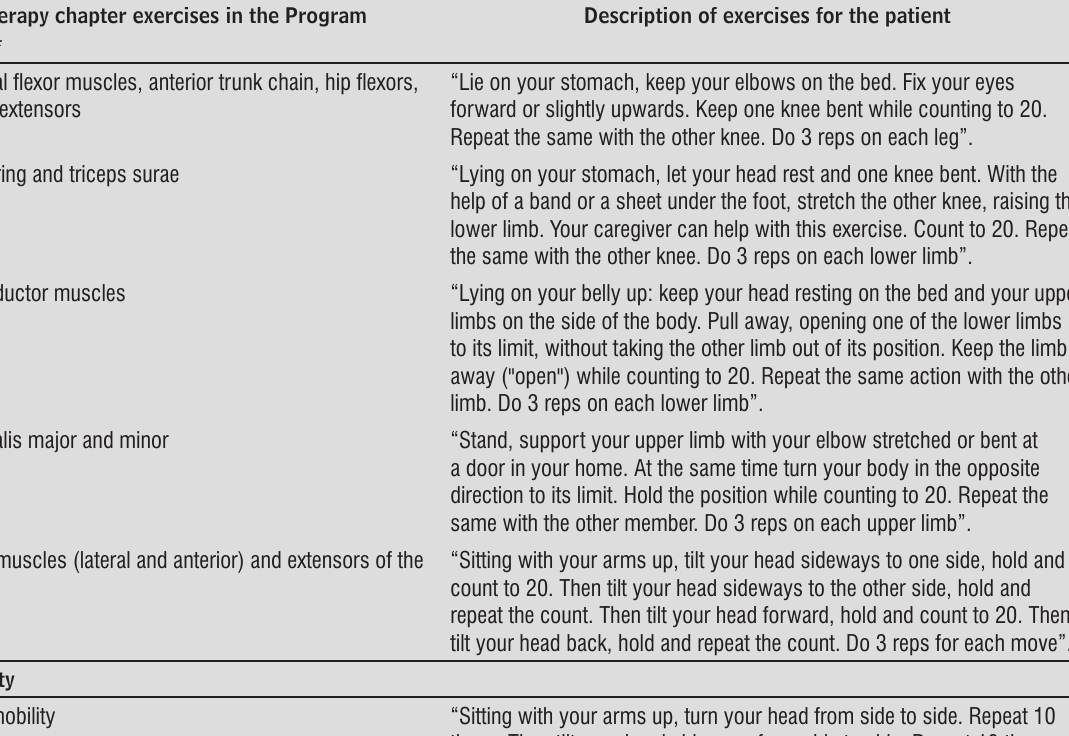
Table 1 - Details of the therapeutic exercises present in the physiotherapy chapter of the program